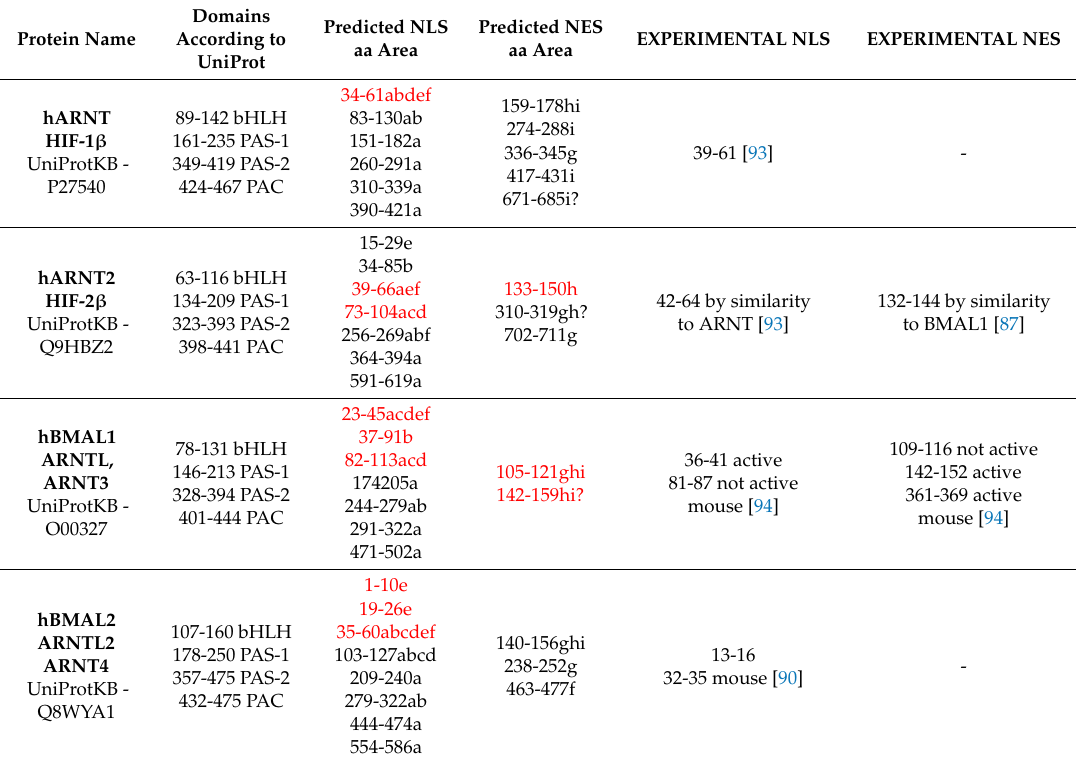
Table 2. Summary of predicted and documented NLSs and NESs in Class II bHLH-PAS